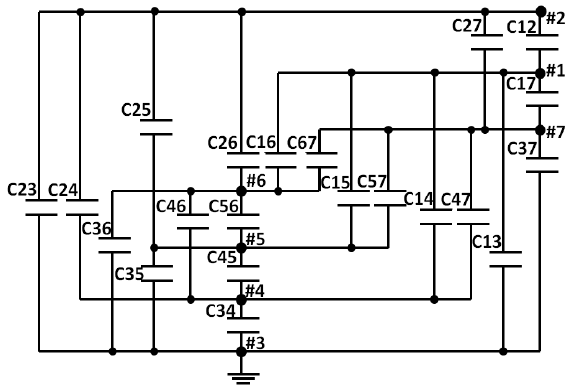
Figure 10. Lumped-parameter equivalent circuit.